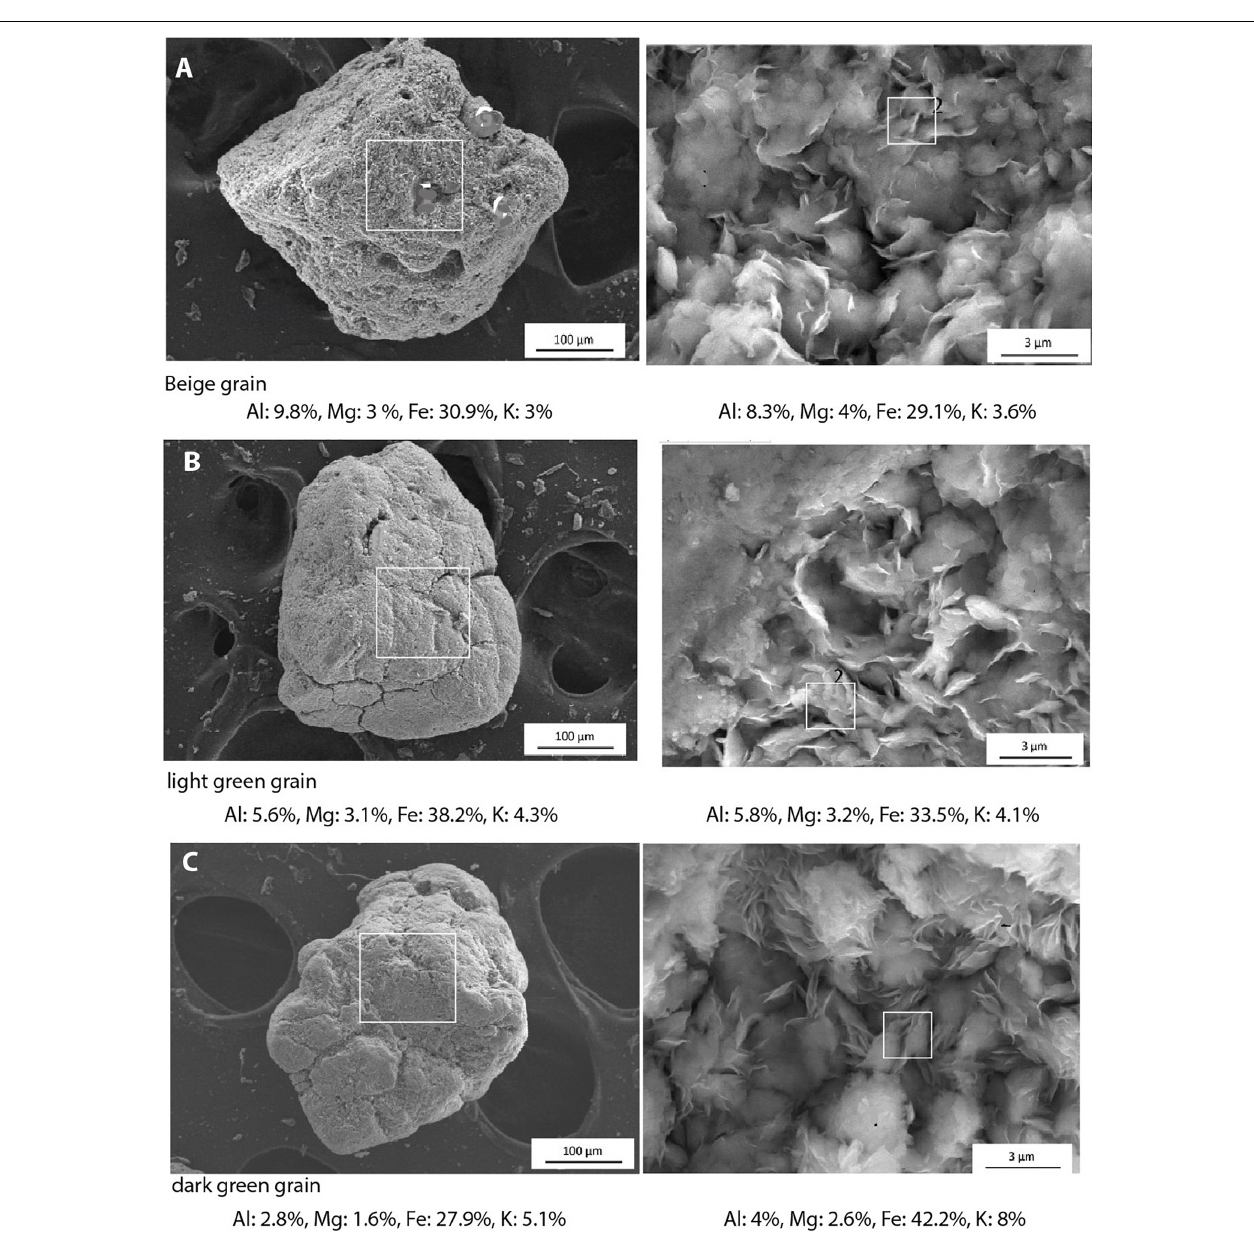
FIGURE 5 | Structural, microstructural, and chemical compositions of the successive glauconitic sequence in core IG-KSF-11. (A) Beige grain exhibiting high porosity (left side), showing microstructural evidence of neoformed glauconitic microcrystals (right side). (B) Light green grain with minor cracks (left side), exhibiting honeycomb development of newly formed microcrystals (right side). (C) Hummocky dark green grain with marked cracks (left side), showing high density of newly formed microcrystals (right side). Note that the white squares indicate microscanned SEM/EDS areas, with corresponding chemical compositions.